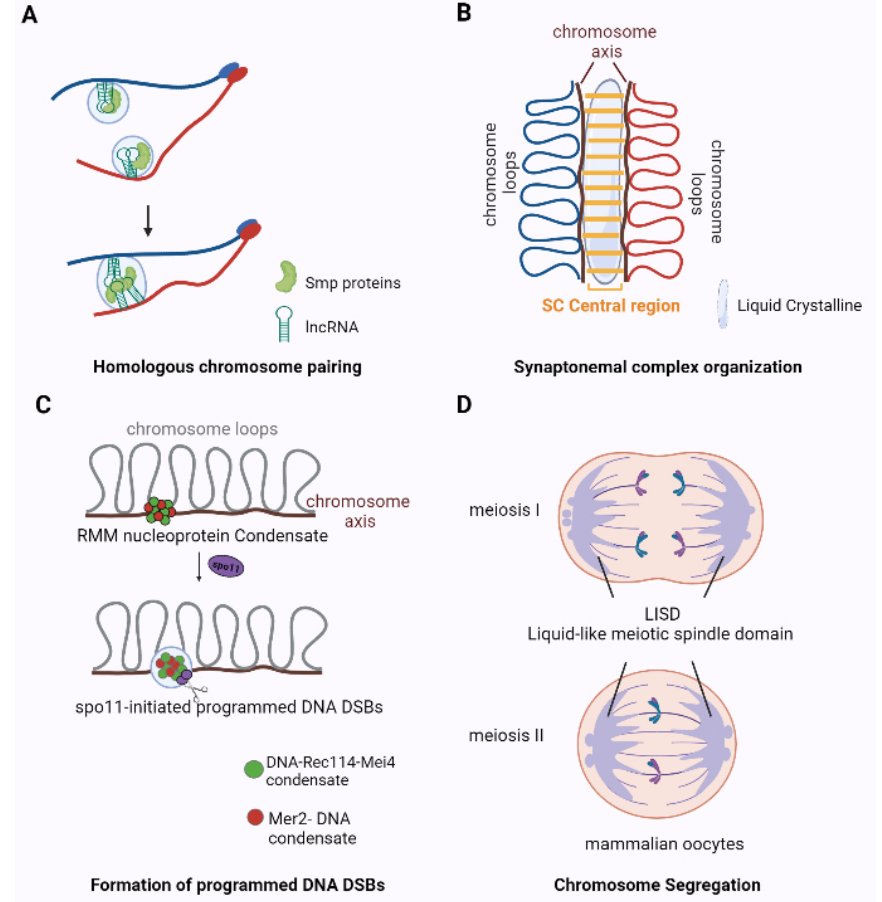
Figure 4. The role of phase separation in meiosis. ( A ) RNA–protein complexes promote the pairing of homologous chromosomes. Blue and red lines represent a set of homologous chromosomes held together at the telomeres. Homologous droplets (Smp proteins and IncRNA) fuse together, facilitating the pairing of homologous chromosomes. ( B ) Phase separation drives SC assembly. Weak interactions between SC central region proteins drive SC assembly, endowing the SC a liquid-crystalline property. ( C ) DNA-driven condensation assembles meiotic DSB formation machinery. Rec114-Mei4 and Mer2 independently condense with DNA into nucleoprotein clusters and then recruit Spo11 to induce DSB formation by phase-separated systems. ( D ) Liquid-like meiotic spindle domain (LISD) during meiosis I and meiosis II in mammalian oocytes. LISD promotes meiotic spindle assembly by selectively concentrating multiple microtubule regulatory factors and allows them to diffuse rapidly within the spindle volume.